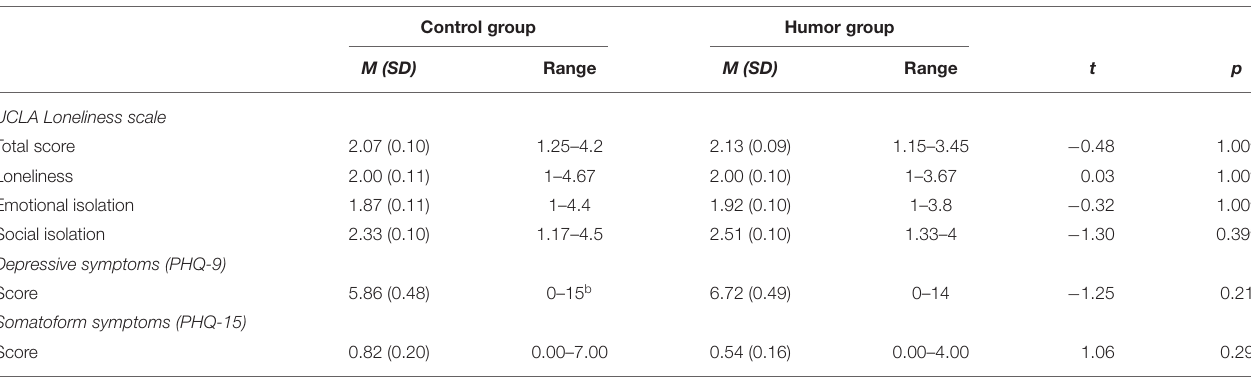
TABLE 2 | Group characteristics with respect to physical and mental